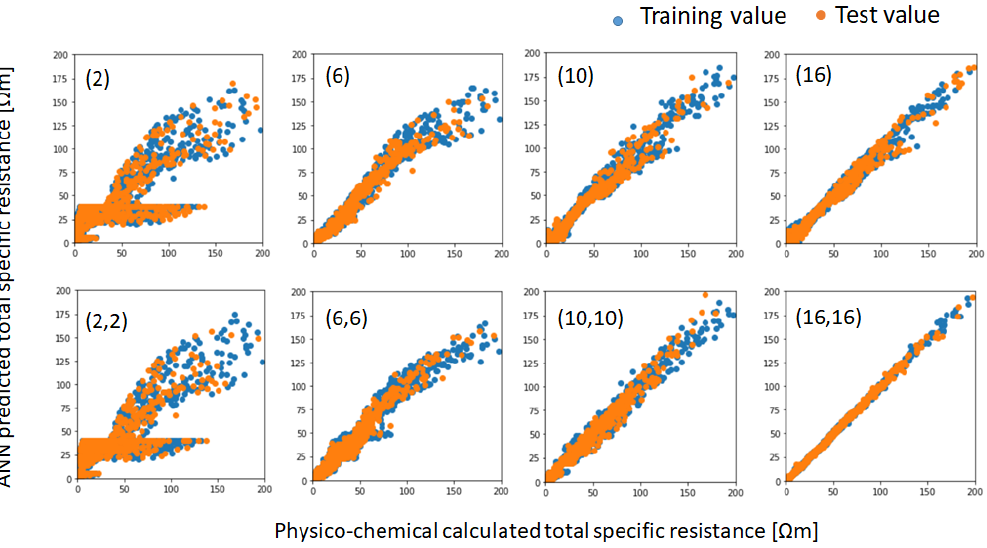
Figure 7. Scatter plots between the specific resistances calculated by the simplified physico-chemical models and predicted by various artificial neural network (ANN) models with training data and test data.